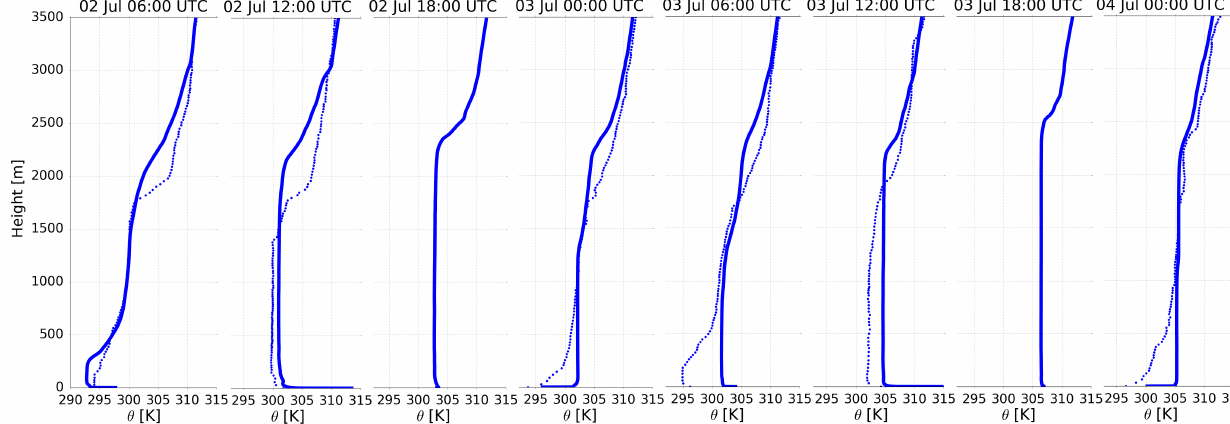
Figure 19. As for Fig. 7 for the idealized simulation with an enlarged domain (see Sect. 4).